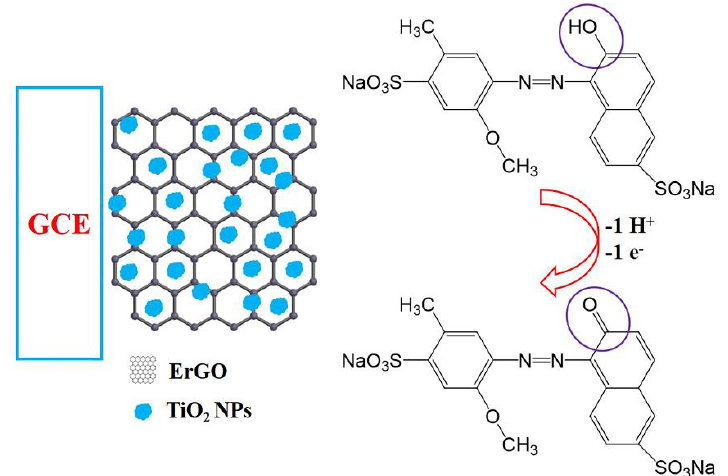
Scheme 1. Schematic diagram of the electrochemical mechanism for the redox of Allura Red at TiO 2 /ErGO/GCE.